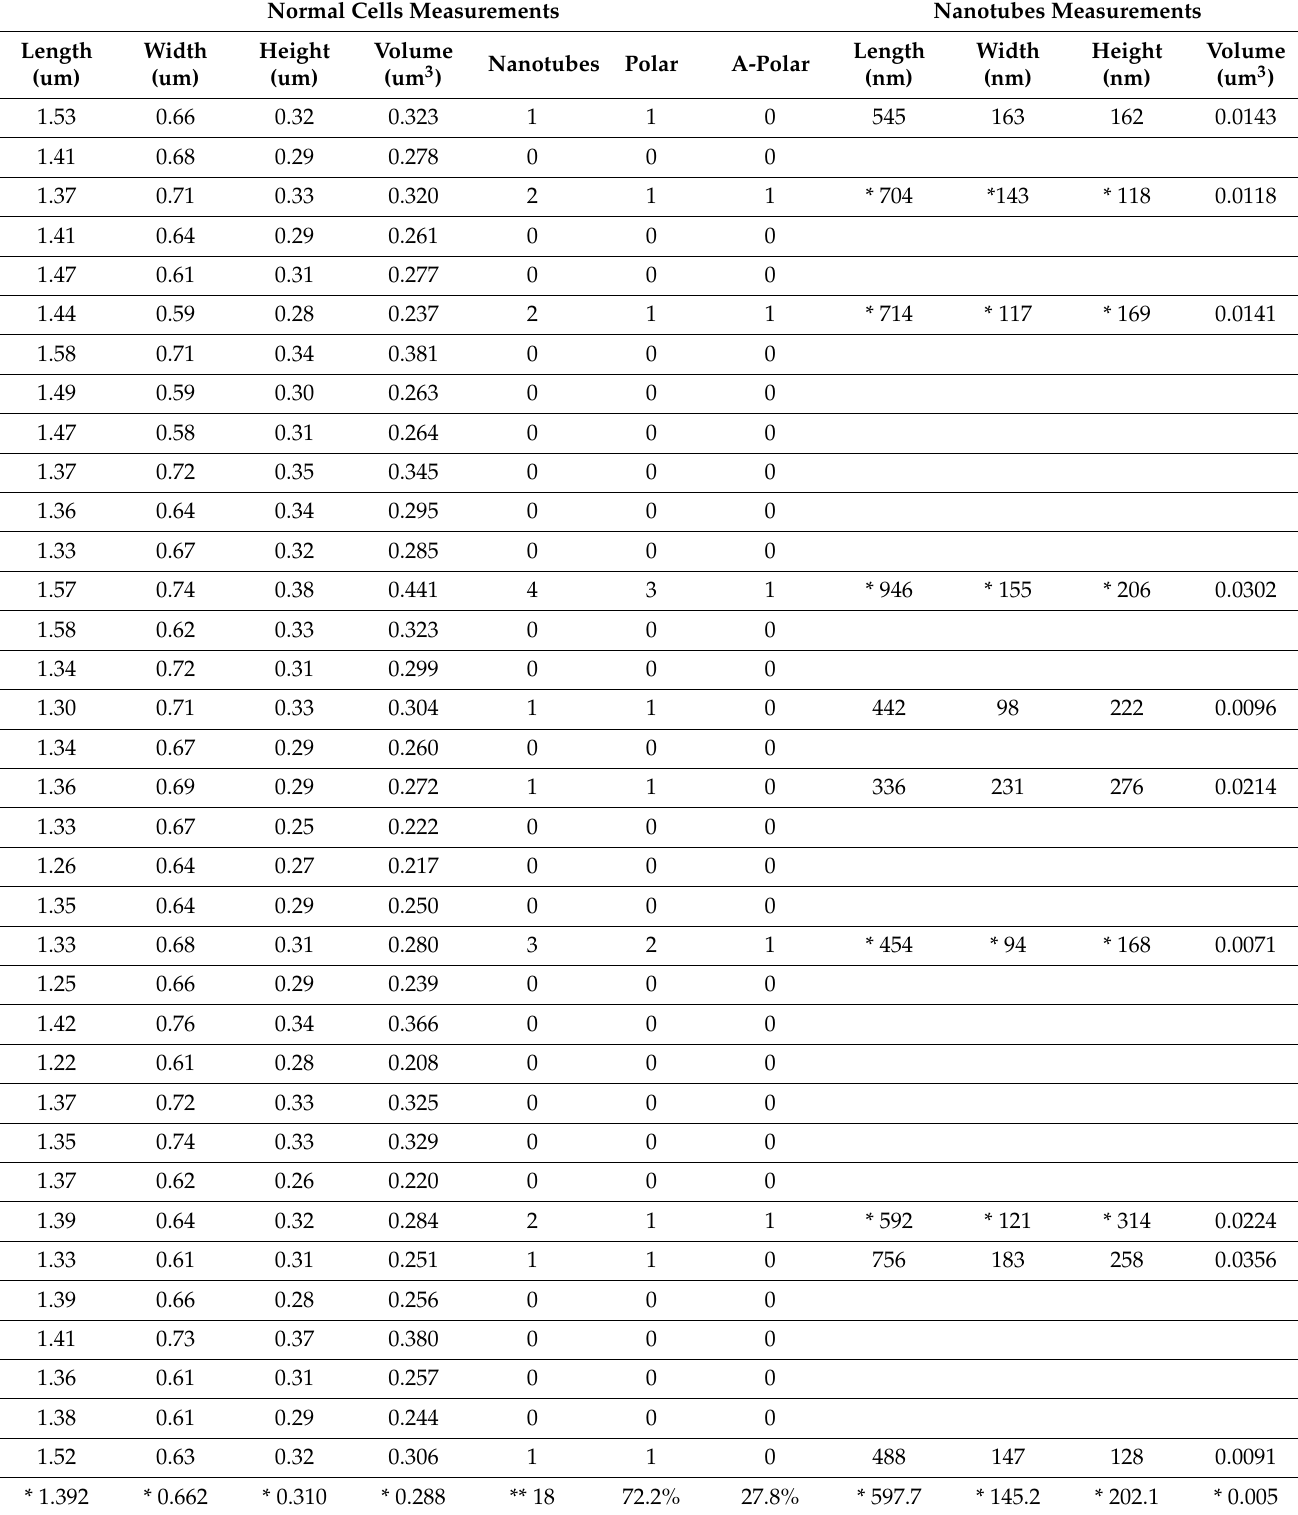
Table 1. Physical Measurements (Total volume including cell length, width and height) of 35 randomly selected cells from a biofilm population of 350 cells. These cells were attached to the glass surface at the lower base of the biofilm consortia. All estimates were analyzed using Gwyddion